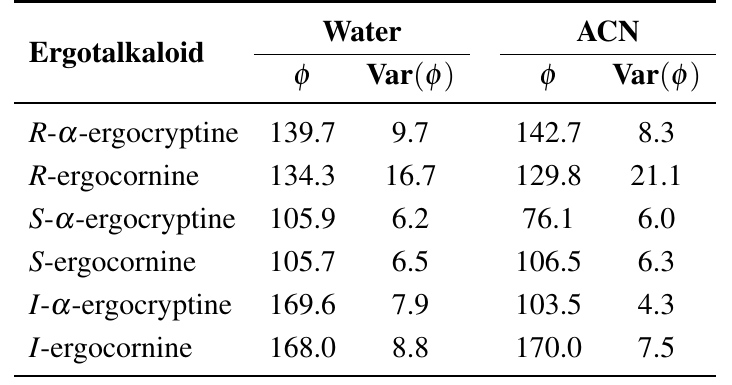
Table 2. The dihedral angle φ is defined by the three chemical bond vectors, consisting of the following four atoms: the nitrogen atom, the keto carbon, the carbon atom C X and its adjacent sp2-hybridized ring carbon ( cf. Figure 1). The mean angle φ and its variance Var ( φ ) are determined once in each of the solvents water and acetonitrile